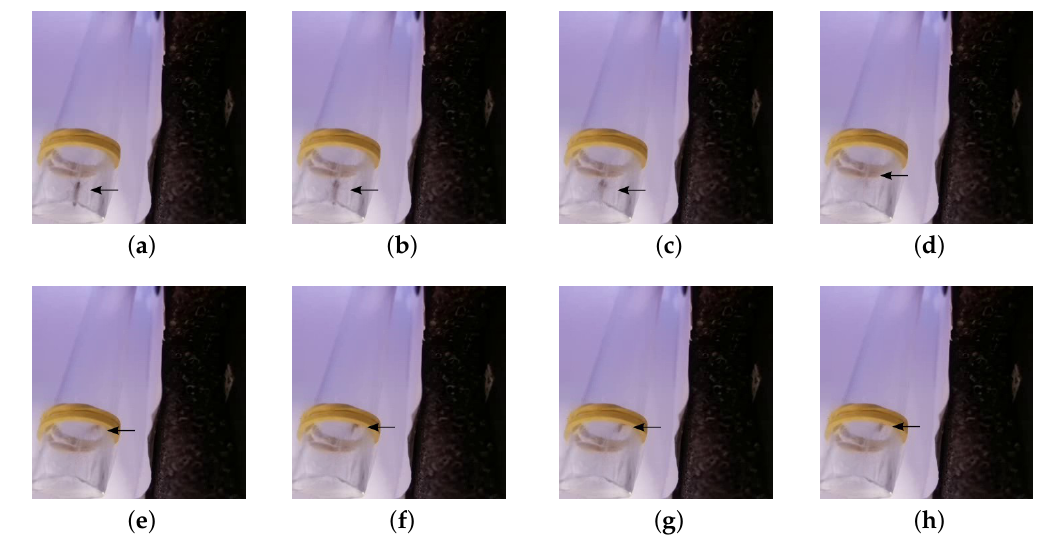
Figure 8. Equidistant time series of video frames captured during a mosquito measurement. The corresponding measurement results are shown in Figure 7a,b. ( a ) t = 0.037 s. ( b ) t = 0.077 s. ( c ) t = 0.117 s. ( d ) t = 0.157 s. ( e ) t = 0.197 s. ( f ) t = 0.237 s. ( g ) t = 0.277 s. ( h ) t = 0.317 s. Figure 7c,d show the spectrograms obtained from two other mosquito